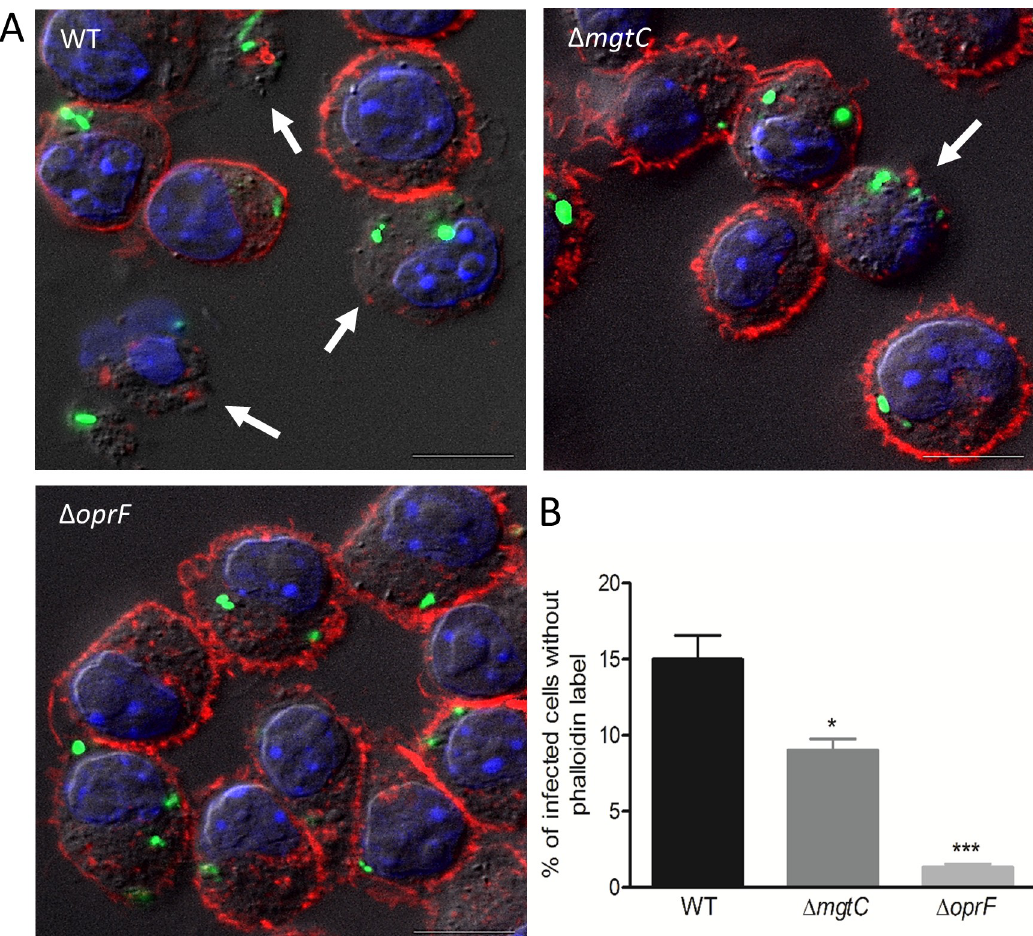
Fig 3. Visualization (A) and quantification (B) of lysed infected cells upon phalloidin labeling. GFP expressing PAO1 WT, Δ mgtC and Δ oprF strains were used for infecting J774 macrophages. Gentamicin was added after phagocytosis and cells were fixed at 2 hrs post-phagocytosis, stained with phalloidin and imaged with fluorescent microscope. DAPI was used to stain the nucleus. Cells that have intracellular bacteria, but lack the phalloidin cortical label were considered as lysed by intracellular bacteria (shown by arrows). Scale bar is equivalent to 10 μ m. After imaging, infected cells were counted and percentage of lysed cells with intracellular bacteria out of total number of cells was plotted for each strain. Error bars correspond to standard errors from three independent experiments. At least 200 cells were counted per strain. The asterisks indicate P values (One way ANOVA, where all strains were compared to WT using Dunnett’s multiple comparison post-test, � P < 0.05 and ��� P < 0.001), showing statistical significance with respect to